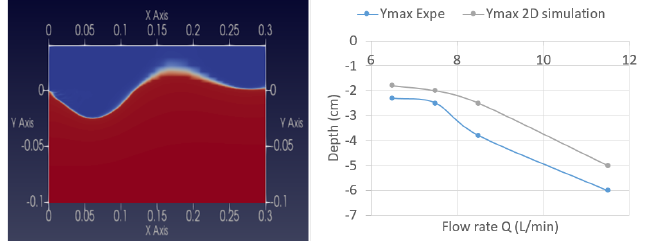
Figure 5: 2D numerical results of the scour and dune formation with Q = 8 . 5 l / min (right) and Y max the maximum erosion depth for di ff erent flow rate Q compared with the experimental data